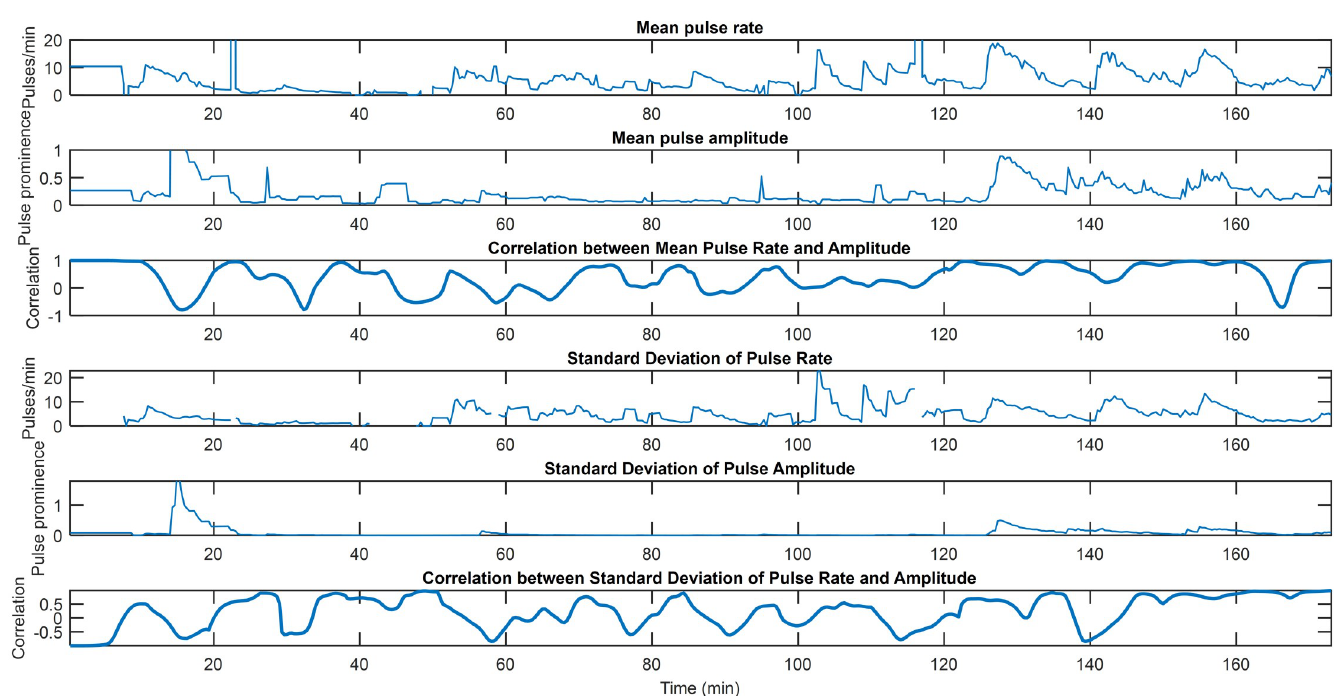
Fig 4. EDA indices from Subject 7. From top to bottom, mean pulse rate, mean pulse amplitude, correlation between mean pulse rate and pulse amplitude, standard deviation of pulse rate, standard deviation of pulse amplitude, and correlation between standard deviations of pulse rate and pulse amplitude. This subject has few periods where pulse rate and amplitude information are highly correlated or highly anticorrelated. They are mostly decorrelated, with the correlation hovering around 0. In this case, pulse rate and amplitude are largely complementary; excluding either would exclude valuable information.